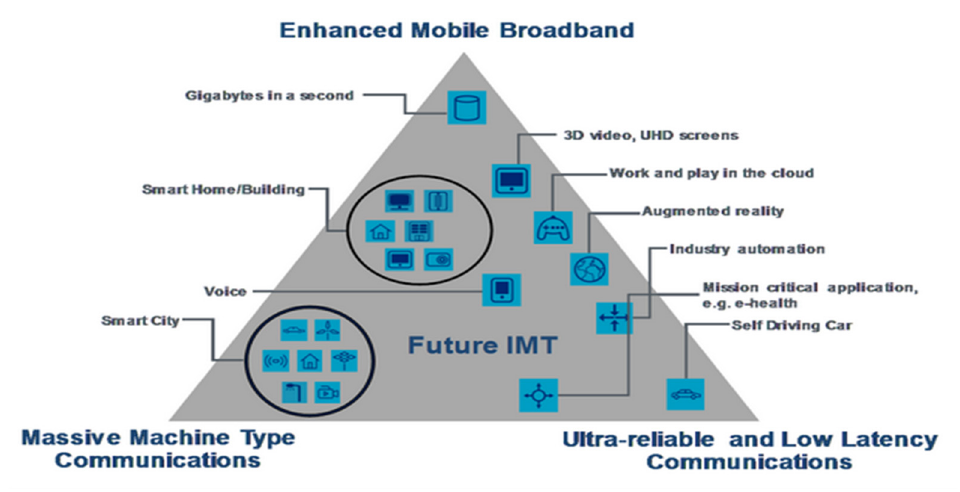
Figure 1. 5G Usage Scenario.